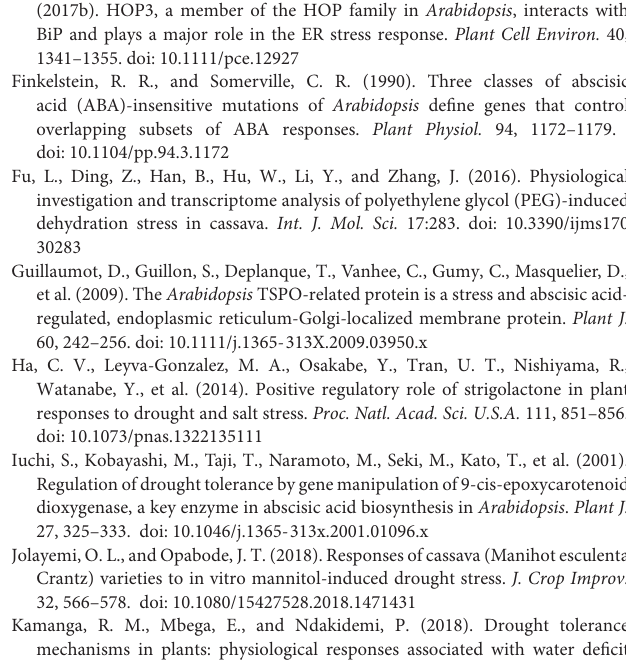
TABLE S1 | Expression of NCED genes that play a key role in ABA biosynthesis. TABLE S2 | Expression data of JA signaling pathway genes, such as COI1 , MYCs , JAZs , and JA biosynthesis pathway genes, such as